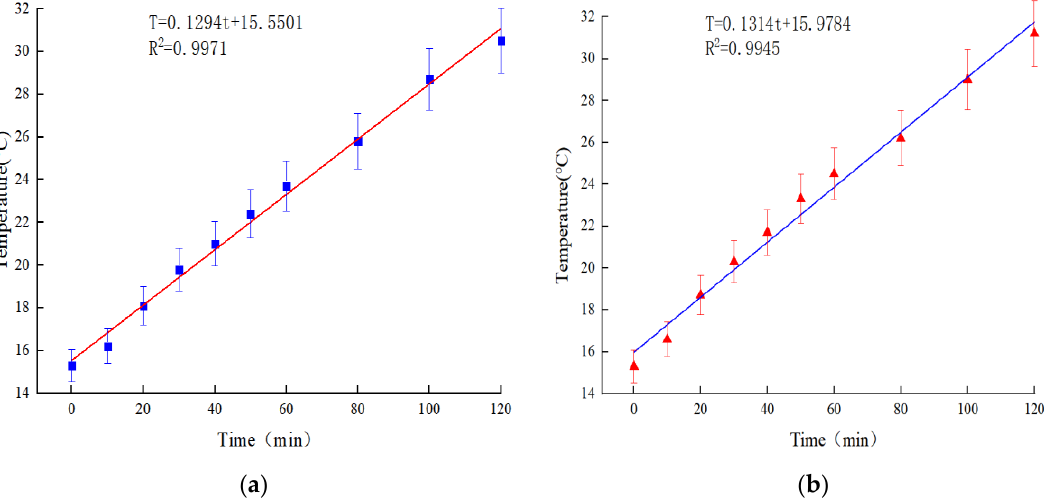
Figure 21. Temperature and electrification time of rut plate specimen. ( a ) 0.3% carbon fiber + 0.5% graphene. ( b ) 0.3% carbon fiber + 0.6% graphene. graphene. ( b ) 0.3% carbon fiber + 0.6% graphene.